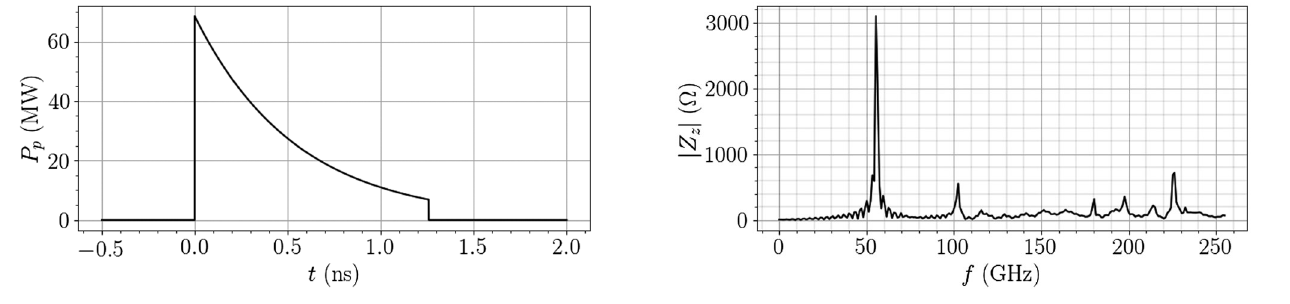
10. Power envelope of the incident TM 01 mode from the output of the 0.5-m long CWG. Calculated with an estimated reduced copper conductivity of σ ¼ 4 × 10 7 S m − 1